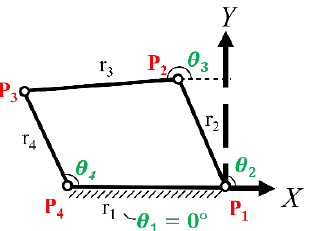
Figure 4. Example of a four-bar linkage structure.